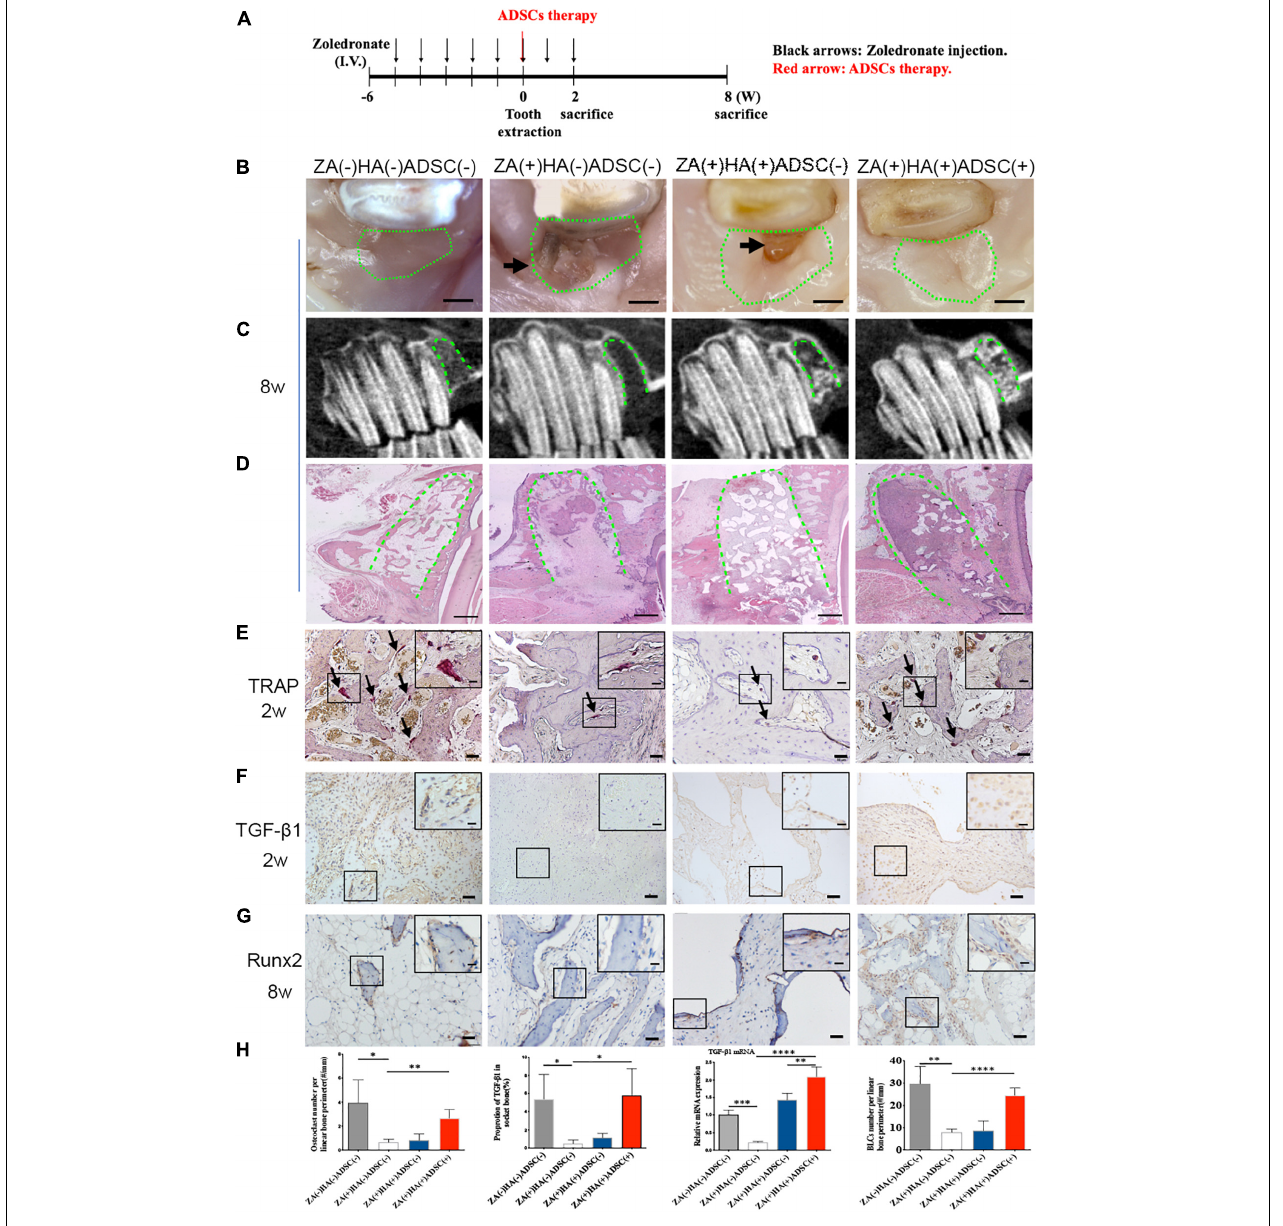
FIGURE 2 | ADSCs local treatment prevents the development of BRONJ-like lesions and enhances bone remodeling in the rabbit model. (A) Schematic diagram of ADSCs therapy. Rabbits were i.v. injected with zoledronate (800 µ g/kg, black arrows) 6 weeks before tooth extraction and ADSCs (red arrow) followed by zoledronate injection for 2 weeks. (B) Representative clinical appearance of gingival wounds at the extraction sites at 8 weeks after tooth extraction. Green circles represent images of the extraction sites, and black arrows indicate the exposed alveolar sockets. Bar: 1 mm. (C) CBCT images in each group. Green dot lines represent alveolar sockets. (D) H&E staining showing bone tissues in alveolar sockets (green dot line). Bar: 1 mm. (E) TRAP staining of alveolar socket showing osteoclasts (black arrows) in each group 2 weeks post-extraction. Insets show magnified boxed regions. Bar: 50 µ m; bar of magnified image: 20 µ m. (F) IHC showing TGF- β 1 expression in alveolar sockets. Bar: 50 µ m, bar of magnified image: 20 µ m. (G) IHC of Runx2 in BLCs. Bar: 50 µ m, bar of magnified image: 20 µ m. (H) Quantification of osteoclast number, TGF- β 1 expression, gene expression of TGF- β 1 in bone tissue of alveolar sockets by qRT-PCR, and Runx2-positive BLCs number in each group. ZA( ± ), zoledronic acid-treated or untreated; HA( ± ), hydroxyapatite-treated or untreated; ADSCs( ± ), adipose-derived stem cells-treated or untreated. ∗ p < 0.05, ∗∗ p < 0.01, ∗∗∗ p < 0.005, ∗∗∗∗ p < 0.0001.